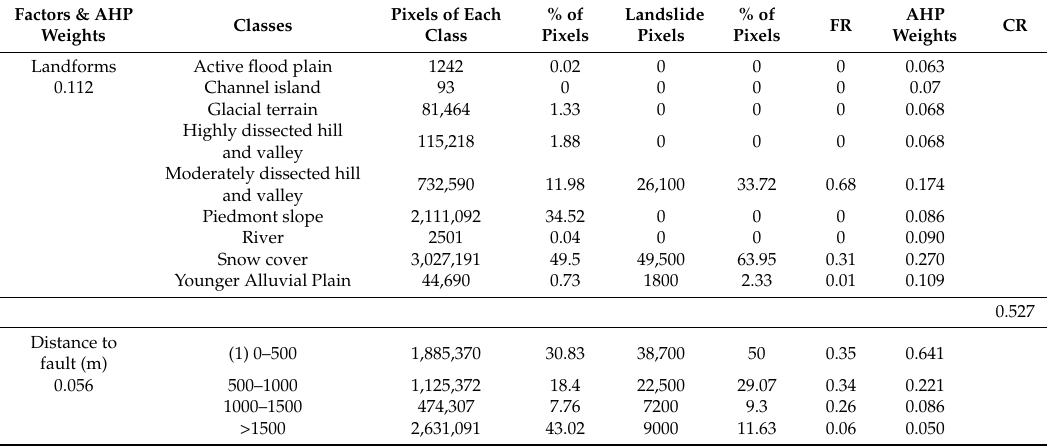
Table 2. The frequency ratio (FR) values and AHP weights for each